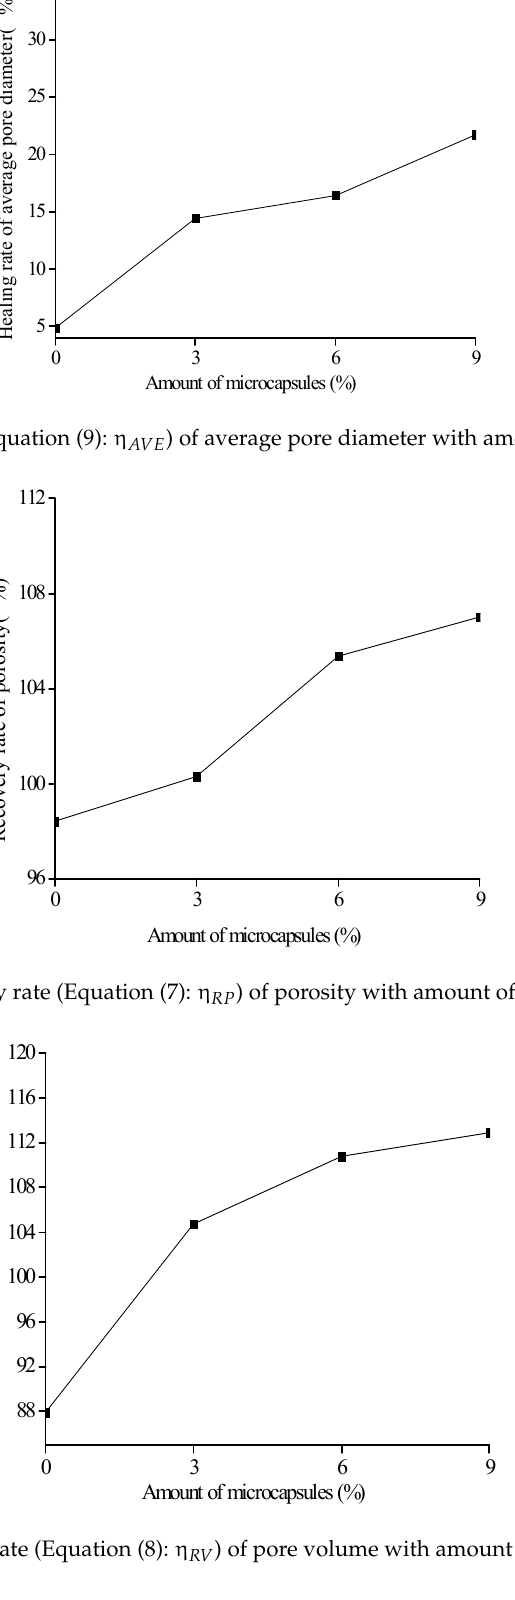
Figure 22. Recovery rate (Equation (8): η RV ) of pore volume with amount of microcapsules.